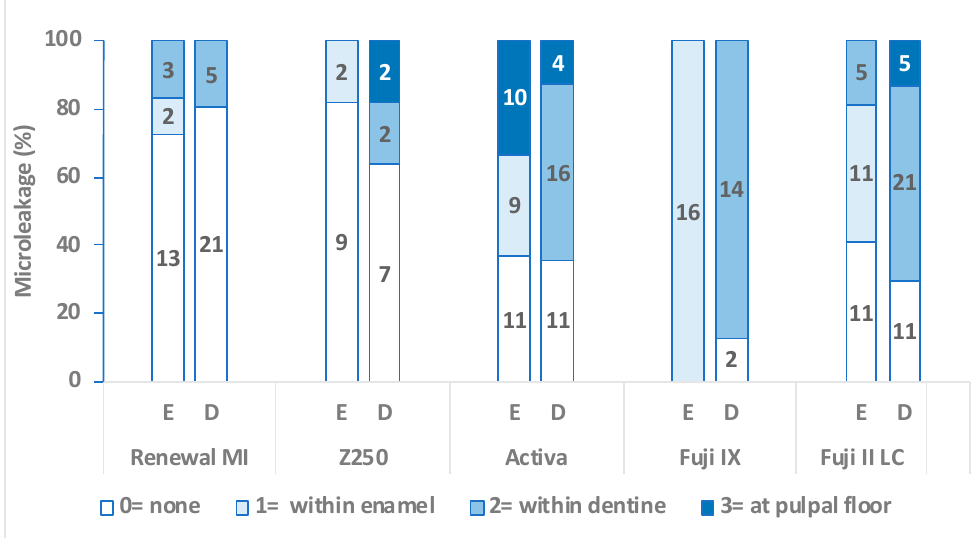
Figure 2. Blue dye microleakage following immersion in water for 24 h at 37 °C. The labels on the bars indicate the numbers of cavities. The y axis indicates this number as a percentage of the total group sample number. The cavosurface was either enamel (E) or dentine (D). The darker the column, the more extensive the dye penetration, and the worse the cavity